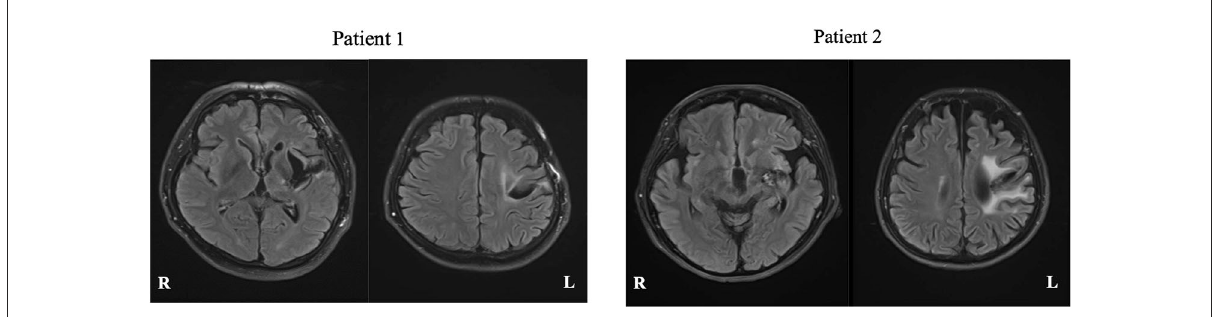
FIGURE3 FLAIR magnetic resonance images of each patient. White matter lesions are seen, reflecting the history of cerebral